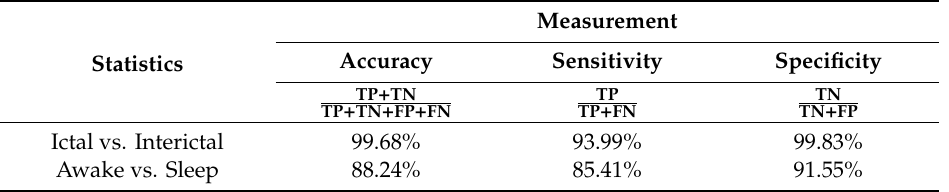
Figure 7. The ensemble average of confusion matrices for classification. The values in each table are averages of the confusion matrices obtained from 10 experiments. In this case, the values in the parentheses are row-wise normalized. Table 2. Statistics for the confusion matrices in Figure 7. The measurements in the table have the following meanings: ‘Accuracy’ represents the overall e ff ectiveness of a classifier, ‘Sensitivity’ represents the e ff ectiveness of a classifier to identify positive labels, and ‘Specificity’ represents how e ff ectively a classifier identifies negative labels. In the formulas for these measurements, the values TP, FN, TN, and FP are used, and they mean ‘true positive’, ‘false negative’, ‘true negative’, and ‘false positive’, respectively. These values are obtained directly from the confusion matrix.